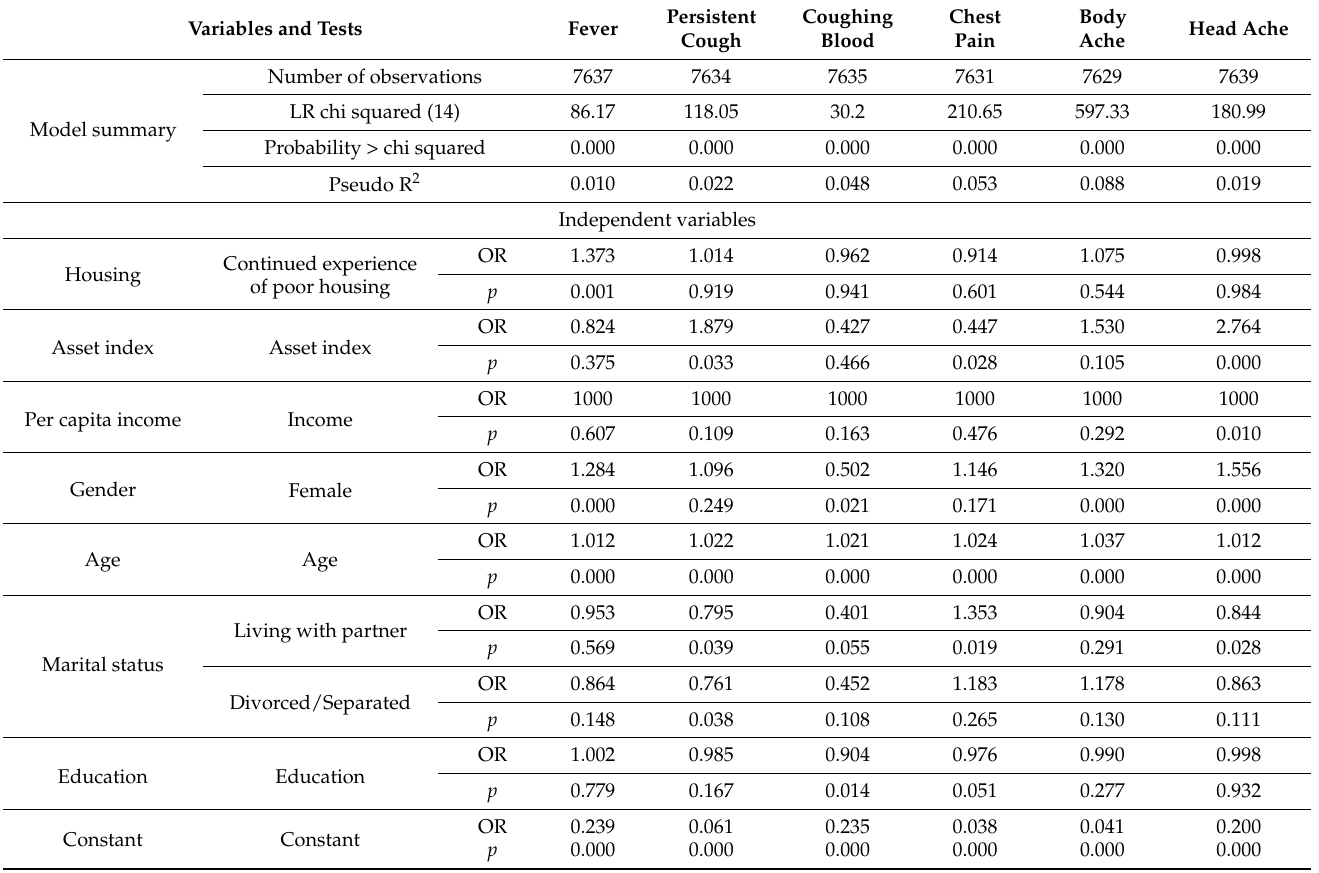
Table 4. Housing and poor health outcomes in the past 30